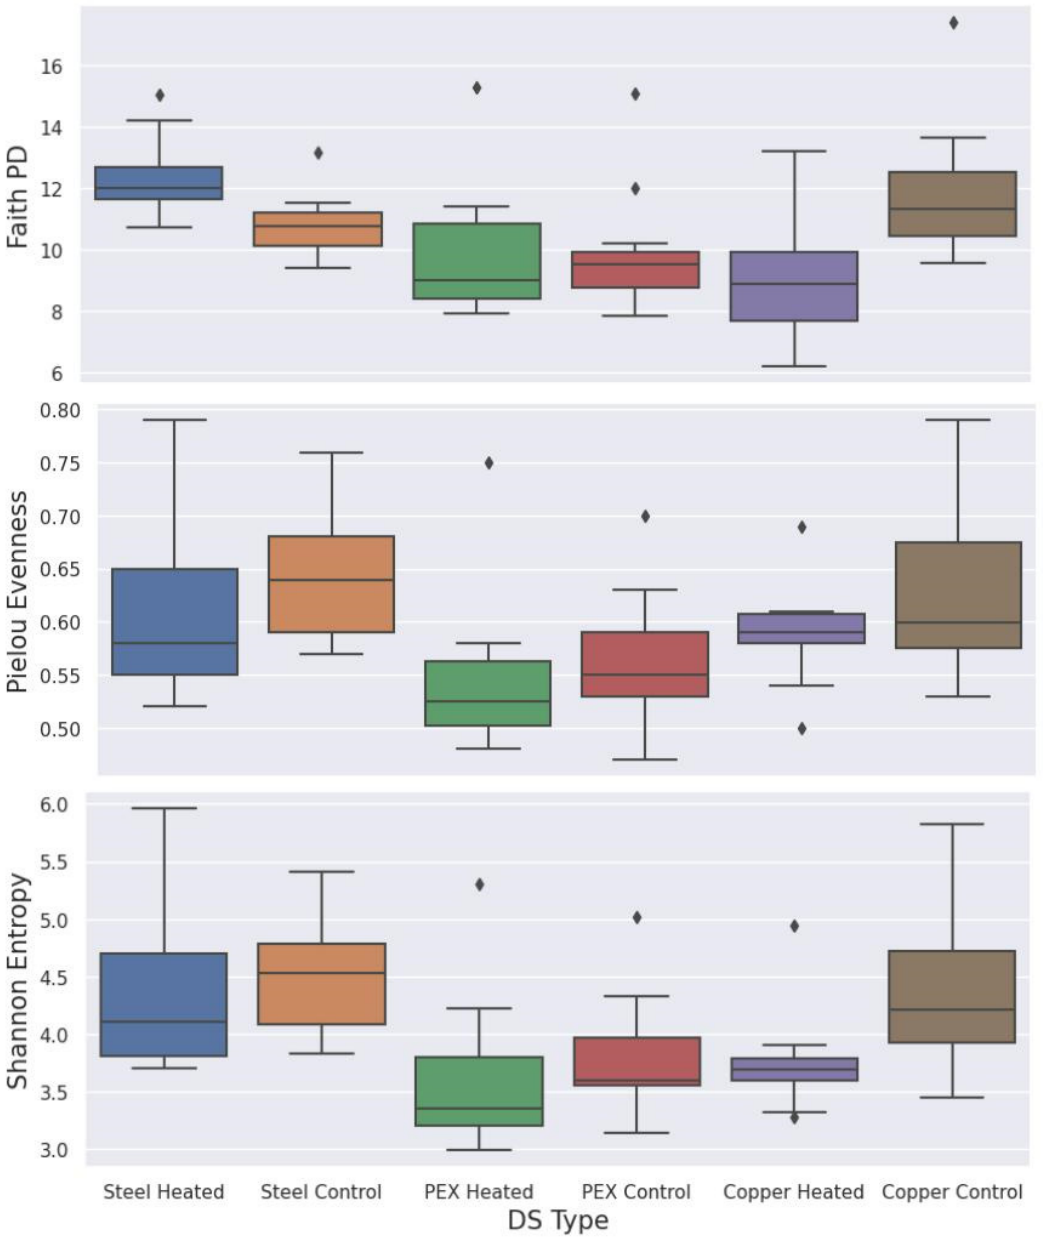
Figure 4. Alpha diversity based on Faith’s PD, Pielou’s evenness, and Shannon entropy metrics.